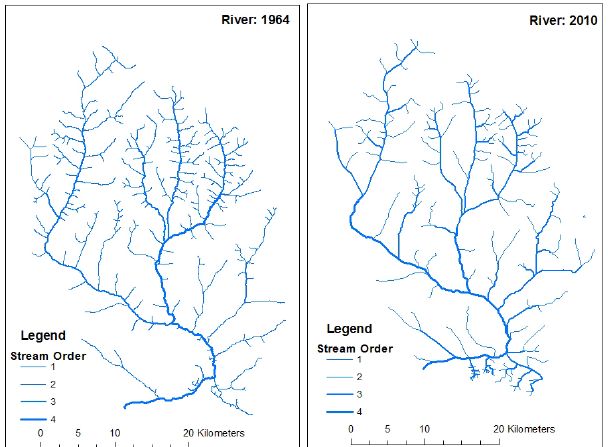
Table 6. Morphometry dynamics of Owo River Basin. Stream